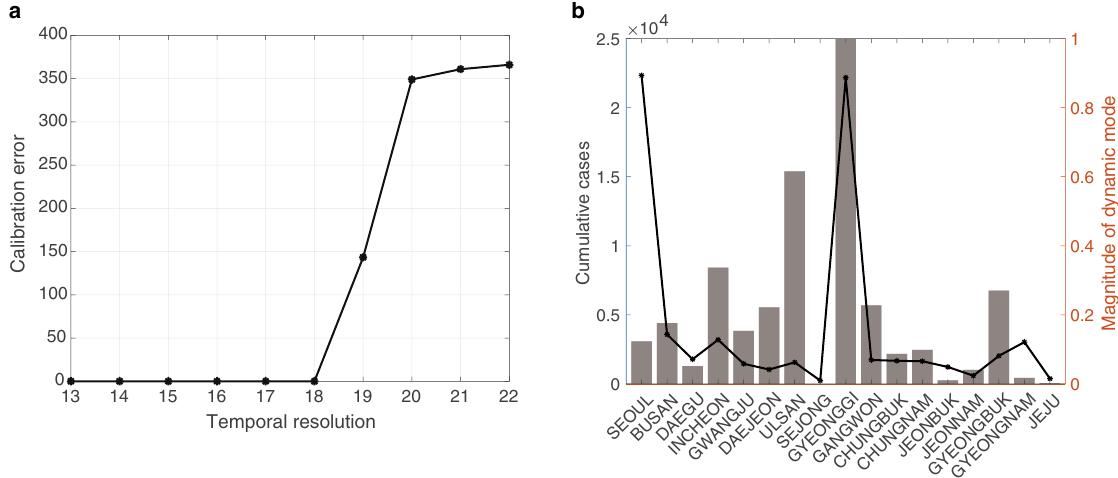
Figure 8. Results showing the inadequacy of the standard DMD applied to incompatible data. ( a ) shows the calibration error as a function of temporal resolutions. The spatial resolution is fixed as 17 and we see that as the temporal resolution becomes larger than 18, the calibration errors start to increase. In ( b ), we consider the total of 19 weeks’ time series data from Dec. 27, 2020–May 8, 2021, which is incompatible with 17 spatial resolution. We selected DMD mode consistently and analyzed its magnitude. Clearly, ( b ) shows that the magnitude does not adequately represent that of data. Recall Figs. 5 and 6 are for the compatible windows, in which such erroneous result do not